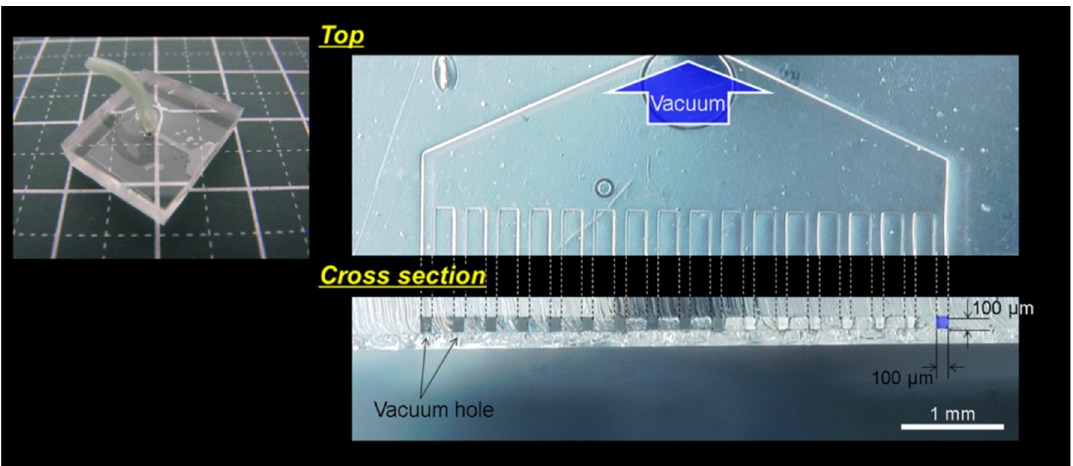
Figure 2. Photo of a micro vacuum check (MVC). The MVC had 17 micro vacuum holes and each hole was a square shape with a side length of 100 μm. The MVC was 5 mm wide.